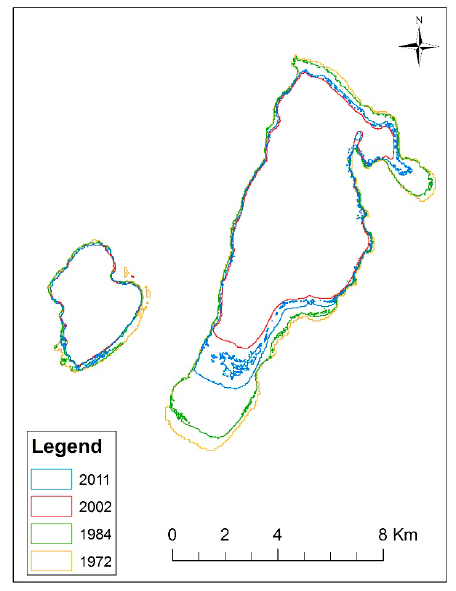
Figure 5. The overlay outlines of the studies lakes delineated from 1972 to 2011.